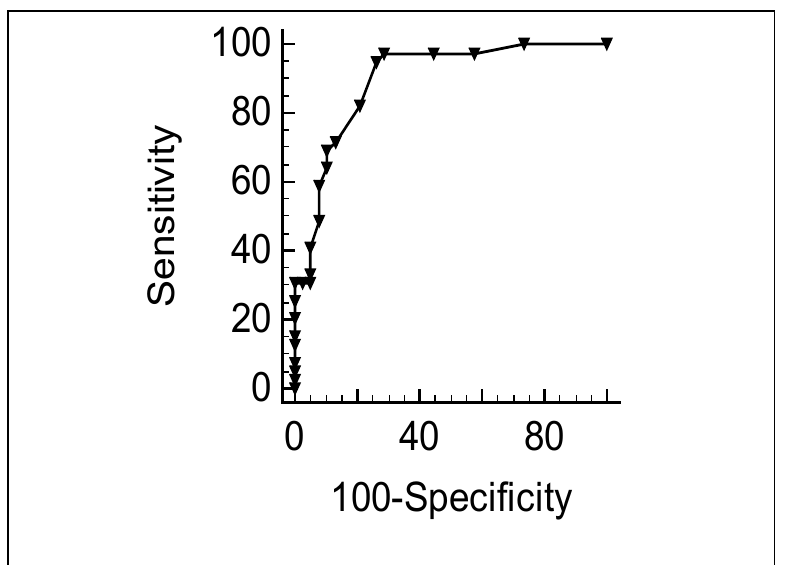
Figure 1. ROC curve plotting MTX intolerance with the questionnaire against the gold standard with cut-off scores of 5, including JIA and relative responses. AUC = 0.90 (95% CI, 0.85–0.94).